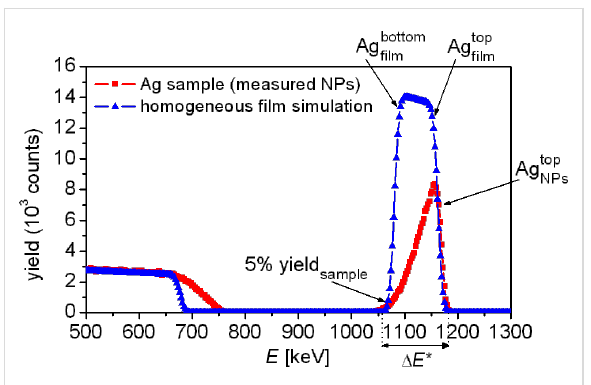
Figure 7: Experimentally recorded RBS spectrum for silver nano- particles synthesized on a silicon substrate (red squares) together with a RBS simulation of a homogeneous silver film (blue triangles). The left shoulder below 750 keV corresponds with the silicon substrate and the right peaks correspond to the silver thin film or the silver nano- particles, as appropriate.